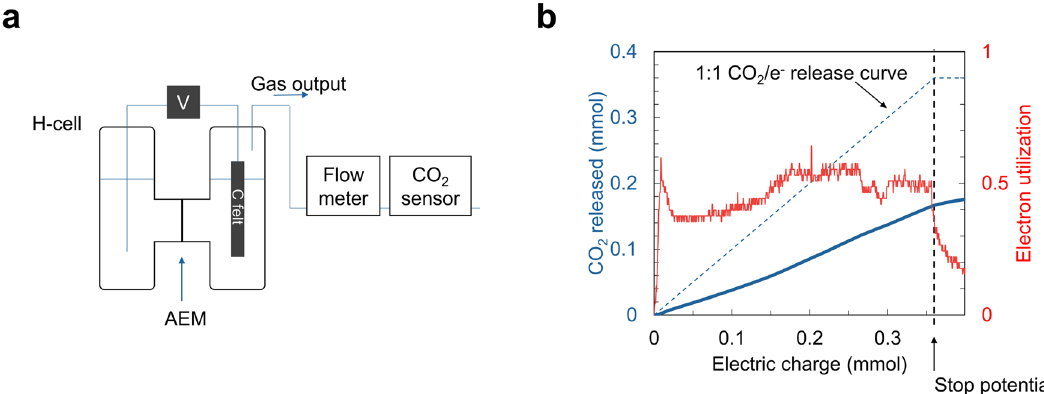
Fig. 3 | Electrochemical release of CO 2 using the NR/NRH2 redox system. a Schematic of the experimental setup for CO 2 release. The electrochemical H-cell containing NRH2 solution to be oxidized by a constant current at room tempera- ture was connected to a gas fl ow meter and an FT-IR CO 2 sensor. AEM: anion